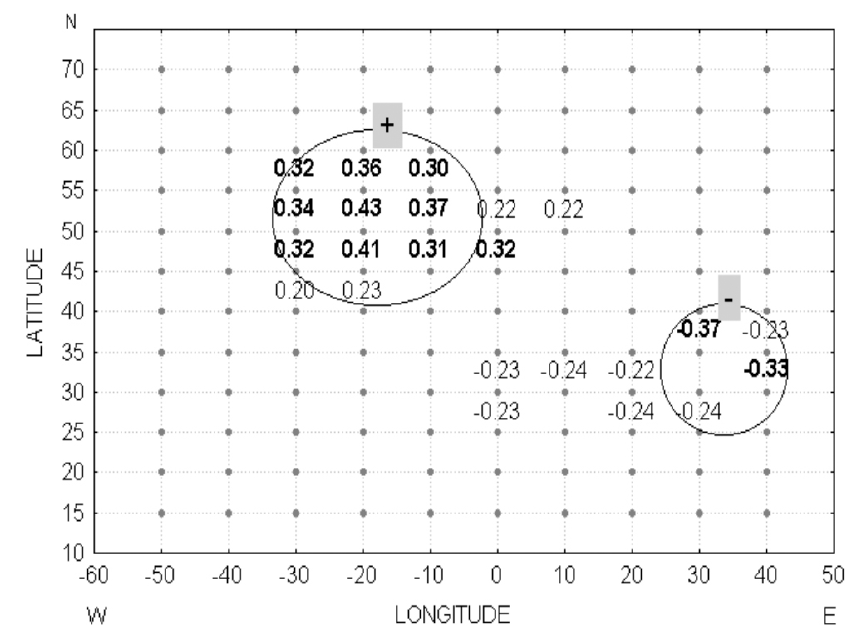
Fig. A1. Spatial distribution of correlation coefficients between SLP data for each grid point and salinity in the intermediary layer of the middle Adriatic. Correlation coefficients significant at the p < 0.05 level are marked in bold. Sign + and - correspond to positive and negative correlation with salinity.